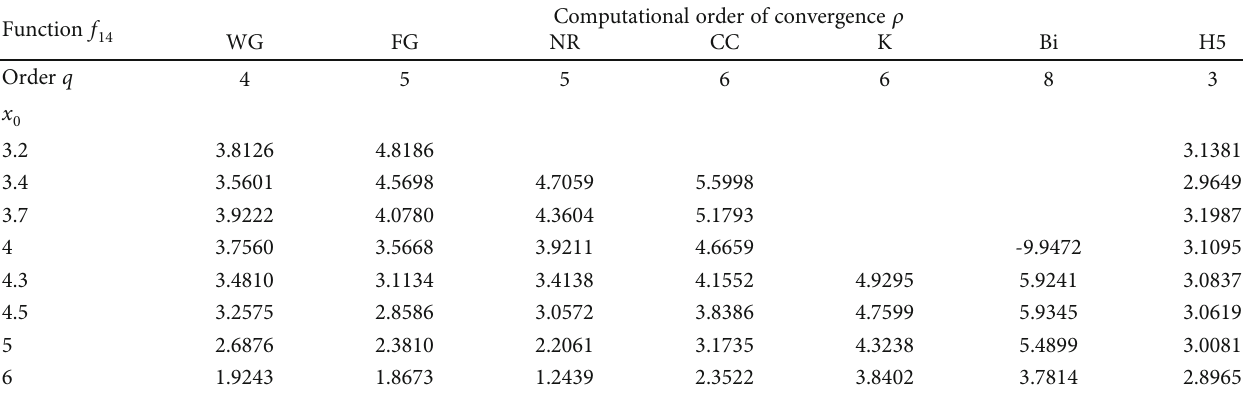
0 , for the test function f 14 .